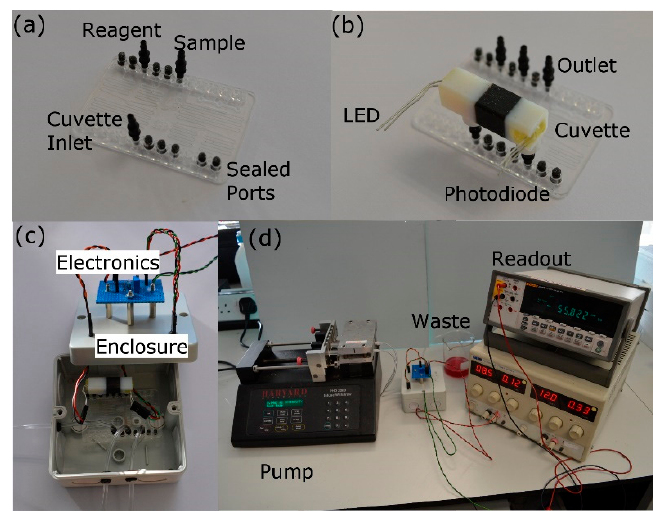
Figure 15. The experimental procedure from chip to system for testing of plastic chip manufactured using the injection moulding process based selective laser melting fabricated tools: ( a ) microfluidic chip with connectors and ( b ) cuvette, and ( c ) and ( d ) entire enclosure and testing system.